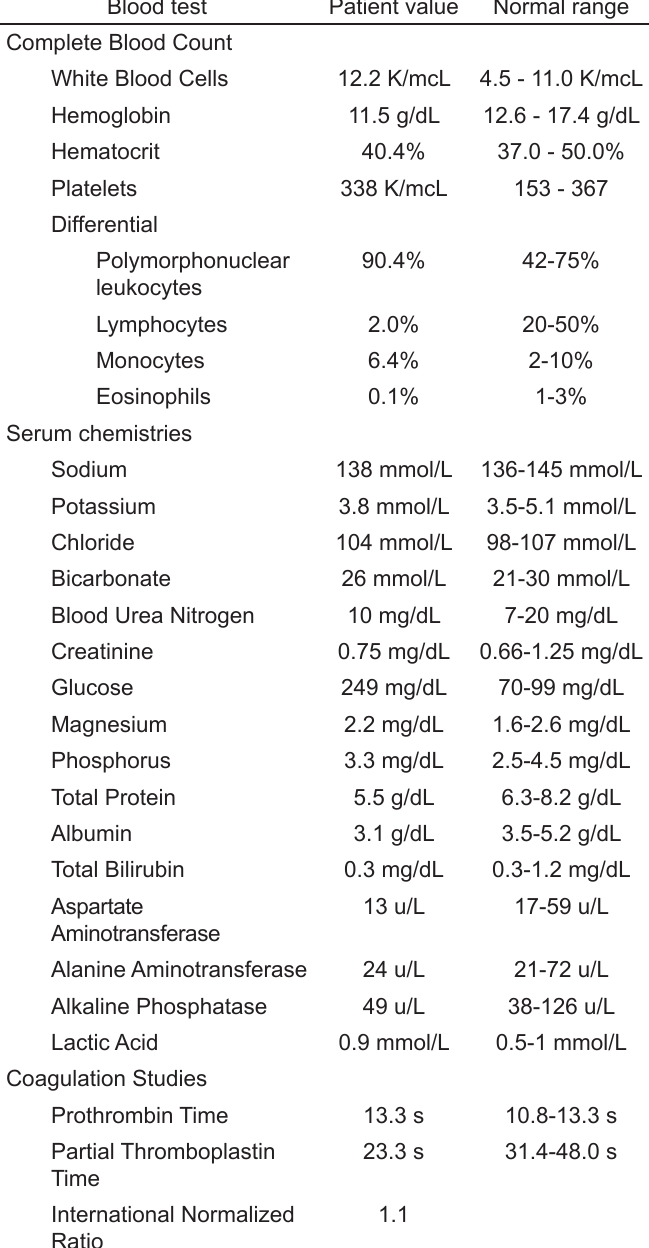
Table 1. Complete blood cell count, serum chemistry and coagulation studies of a 40-year-old female with sudden onset